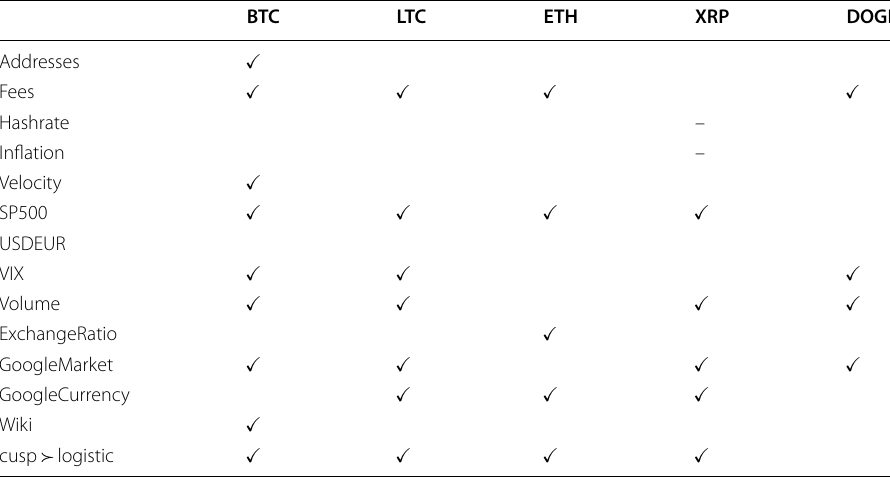
Table 2 Variables remaining in final